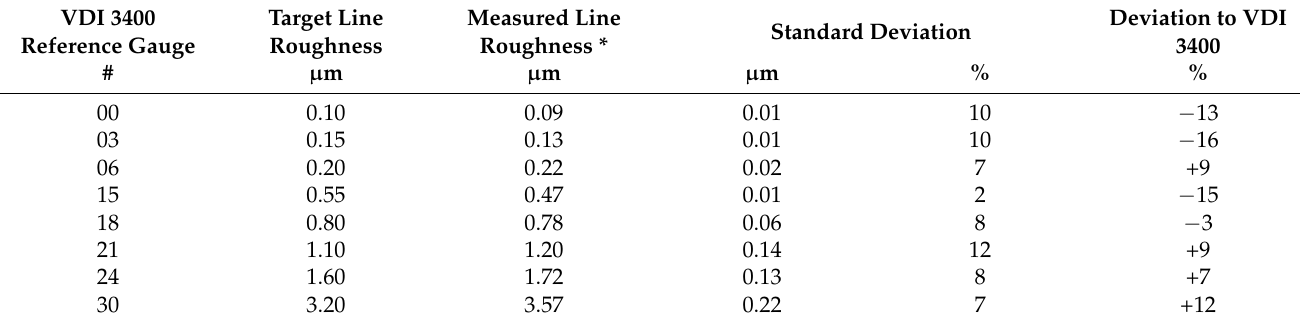
Table 8. Proof of the suitability of the confocal microscope in terms of